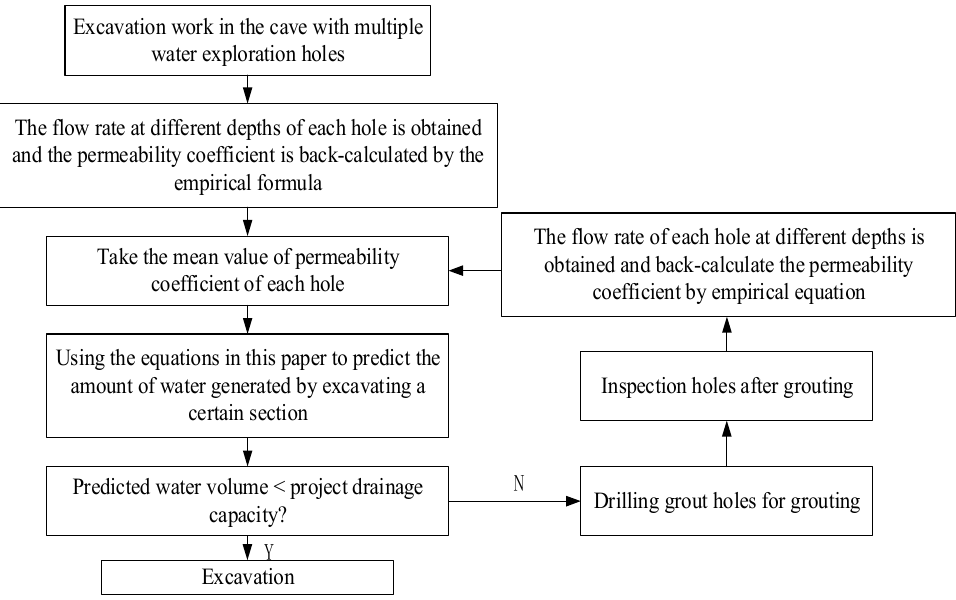
Figure 9. Working face grouting excavation judgment method.